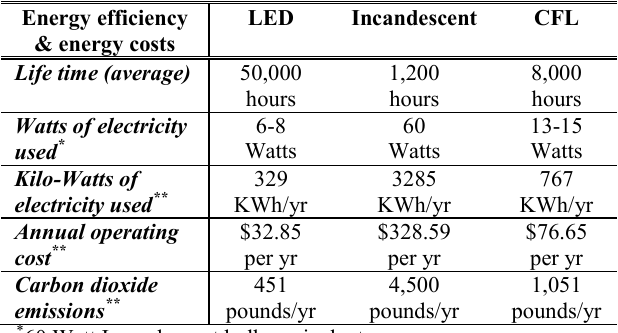
Table 1 Comparison, LED vs. Incandescent vs.